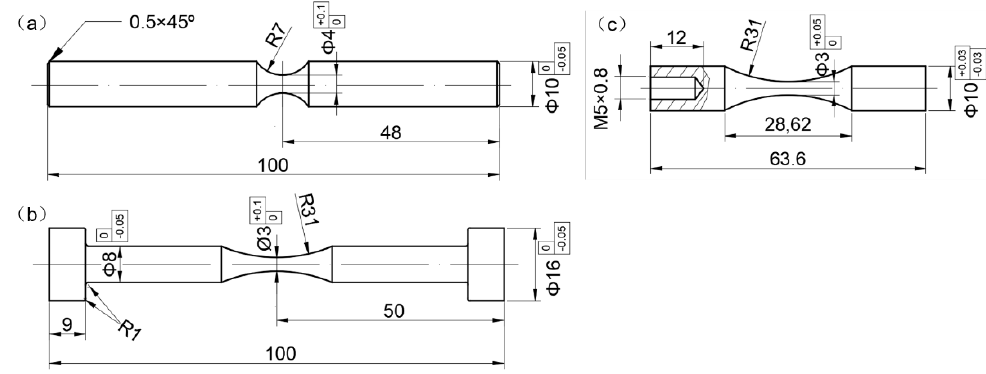
Figure 1. Shape and dimensions (mm) of fatigue test specimens: ( a ) rotary bending (RB) specimen; ( b ) electromagnetic resonance axial loading (EA) specimen; ( c ) ultrasonic axial loading with cooling (UA) or without cooling (UA-NC) specimen.